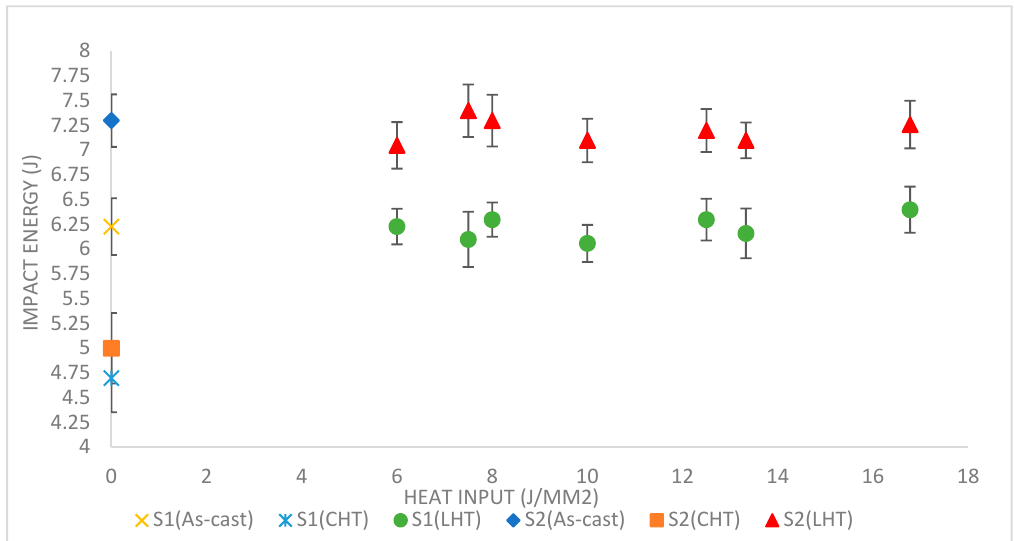
Figure 19. The impact energy profiles of As-cast, CHT and LHT of S1, S2 samples corresponding to laser heat inputs. Error bars represent standard deviation.